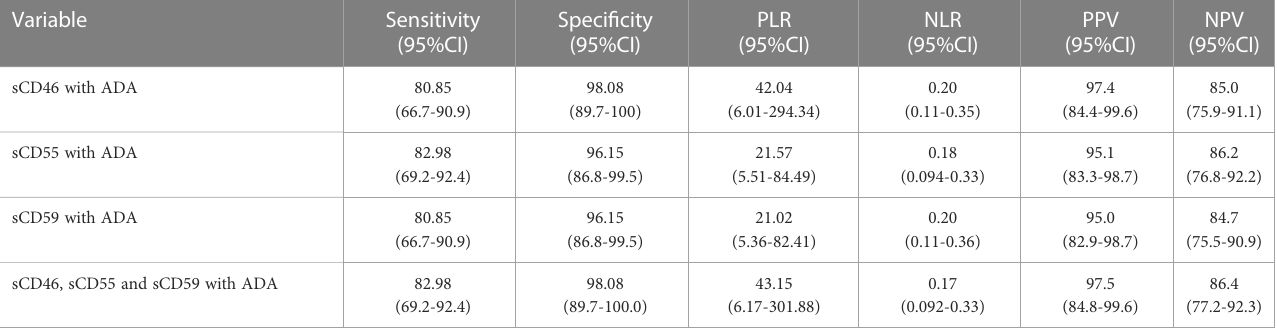
TABLE 4 Diagnostic performance of combined detection of sCD46, sCD55 and sCD59 with ADA in PF. Variable